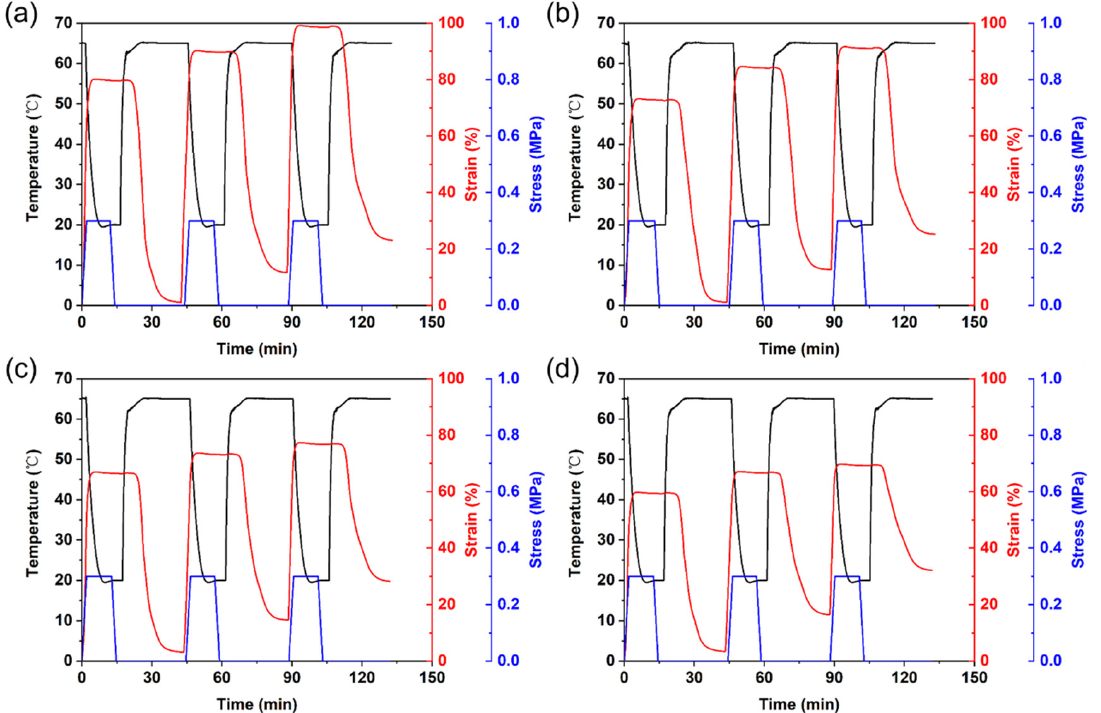
Figure 8. Temperature, strain, and stress curves of the PLA/PCL nanocomposites during the three shape memory cycles: ( a ) PN4-0.25, ( b ) PN4-0.5, ( c ) PN4-0.75, and ( d ) PN4-1. Table 6. R fn and R rn of the PLA/PCL nanocomposites with different CNC-OMMT contents.